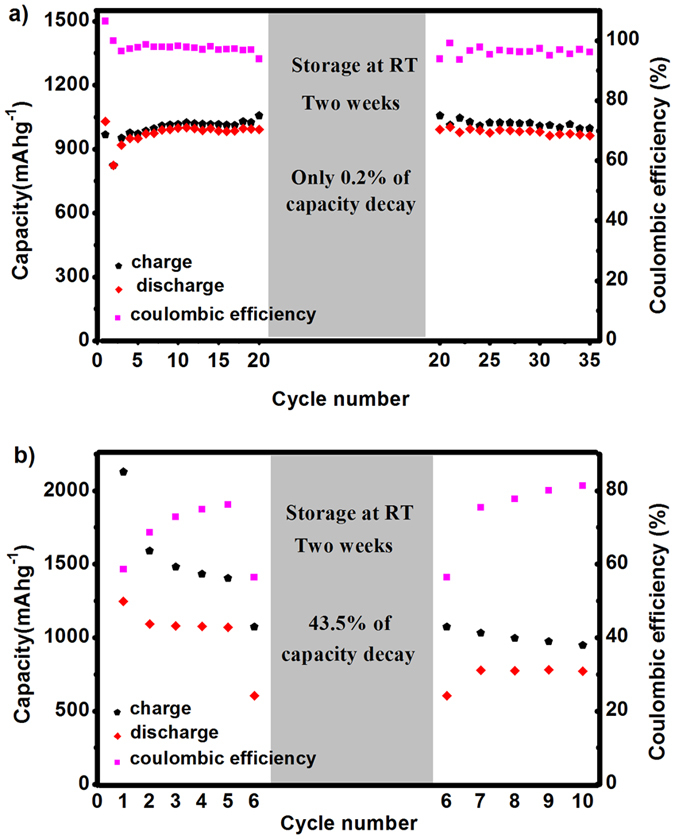
Charge/discharge capacity and coulombic efficiency vs. number of cycles of Li-S cell with (a) PIS electrolyte and (b) 1 M LiTFSI DOL/DME (v/v = 1:1) electrolyte before (1st–19th) and after (21st–35th) a storage time of two weeks.